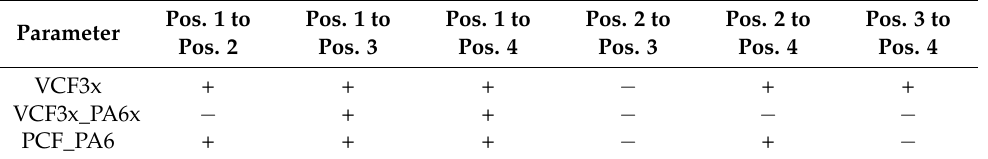
Table 6. Statistical significance between the fiber lengths of the positions (significant difference indicated as “+”, no difference indicated as “ −